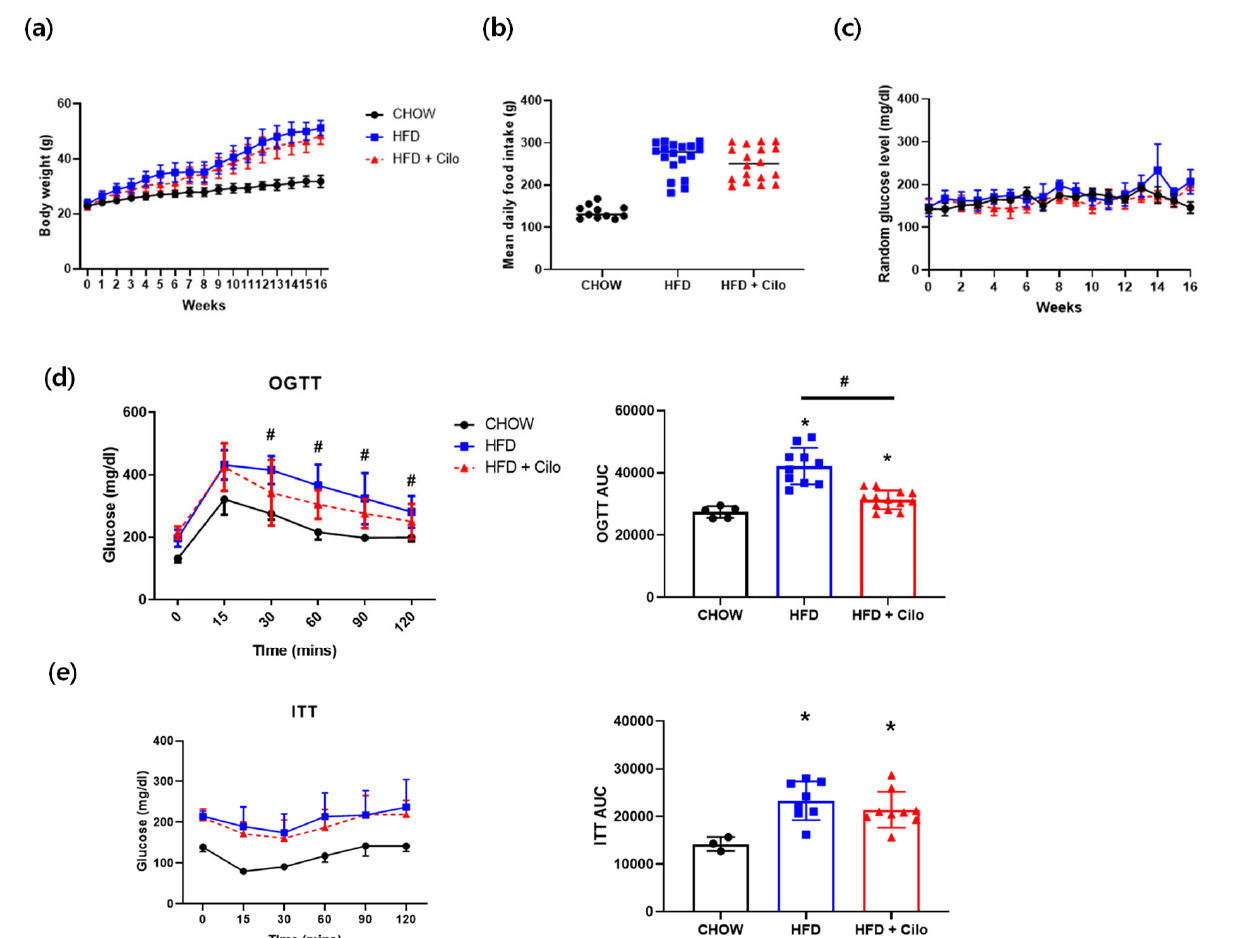
Figure 1. Cilostazol treatment had a modest effect on the bodyweight of mice with HFD-induced obesity and improved glycemic control. For 16 weeks, male C57BL/6J mice were fed with chow or HFD and treated with or without cilostazol. ( a ) Change in body weight; ( b ) average food intake per week; ( c ) changes in the mean random glucose levels during the 16-week experiment; and ( d ) oral glucose tolerance test and differences in the associated AUC; ( e ) insulin tolerance test and differences in the associated AUC. Data are presented as the mean ± standard error. * p < 0.05 vs. corresponding chow control value and # p < 0.05 vs. corresponding HFD control value. HFD, high-fat diet; Cilo, cilostazol; OGTT, oral glucose tolerance test; ITT, insulin tolerance test; AUC, area under the curve.